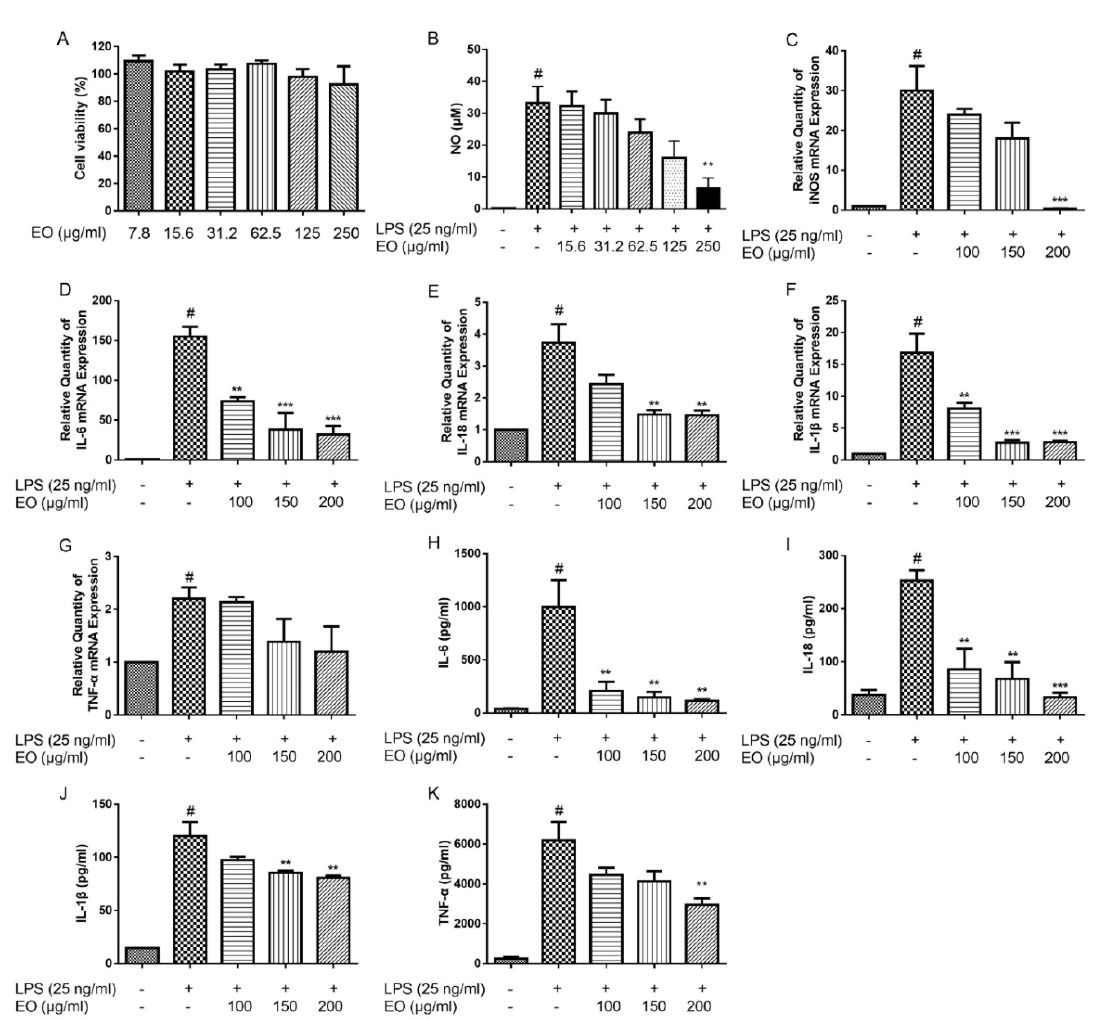
Figure 1. Effect of essential oil (EO) on the viability of BV2 microglial cells ( A ). Effects of EO on lipopolysaccharide (LPS)-induced production of nitric oxide (NO) ( B ) and mRNA expression of iNOS ( C ). Effects of EO on LPS-induced mRNA expression levels of IL-6 ( D ), IL-18 ( E ), IL-1 β ( F ), and TNF- α ( G ) in BV2 microglial cells, and secretion of IL-6 ( H ), IL-18 (I), IL-1 β ( J ), and TNF- α ( K ) in the culture supernatant from BV2 microglial cells. ( # p < 0.05 vs. control, ** p < 0.01, *** p < 0.001 vs. LPS treatment, n = 3).